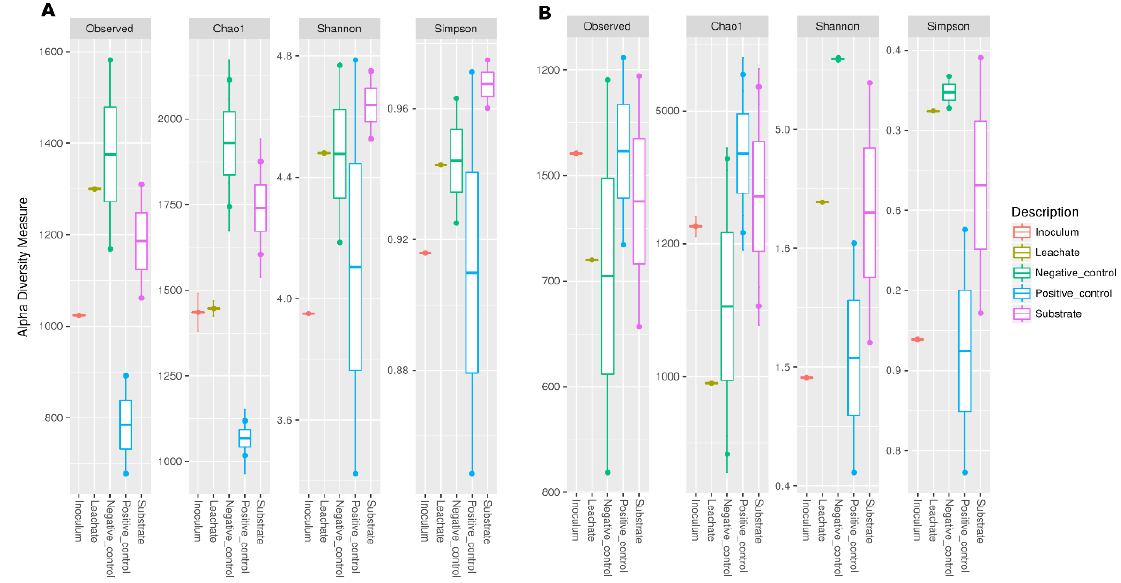
Figure 5. Alpha-diversity of the bacteria ( A ) and archaea ( B ) in the leachate (LCP), inoculum (INCP), and treatment groups (NC, PC, and SB).